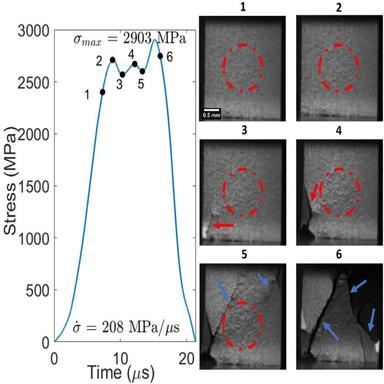
Stress history in dynamic (SHPB) uniaxial compression with corresponding images at six different times. The red arrow shows the formation of the primary crack, the blue arrows shows the formation of the secondary cracks, and the dashed circle indicates the formation of the texturing.